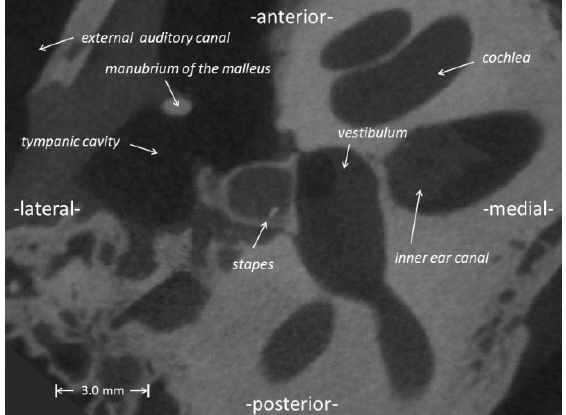
Figure 1. Micro-computer-tomography ( μ CT) slice image showing a part of a human temporal bone with cross-sections of the stapes and the manubrium of the malleus. The light gray areas depict bone. Orientations are marked at the image borders.